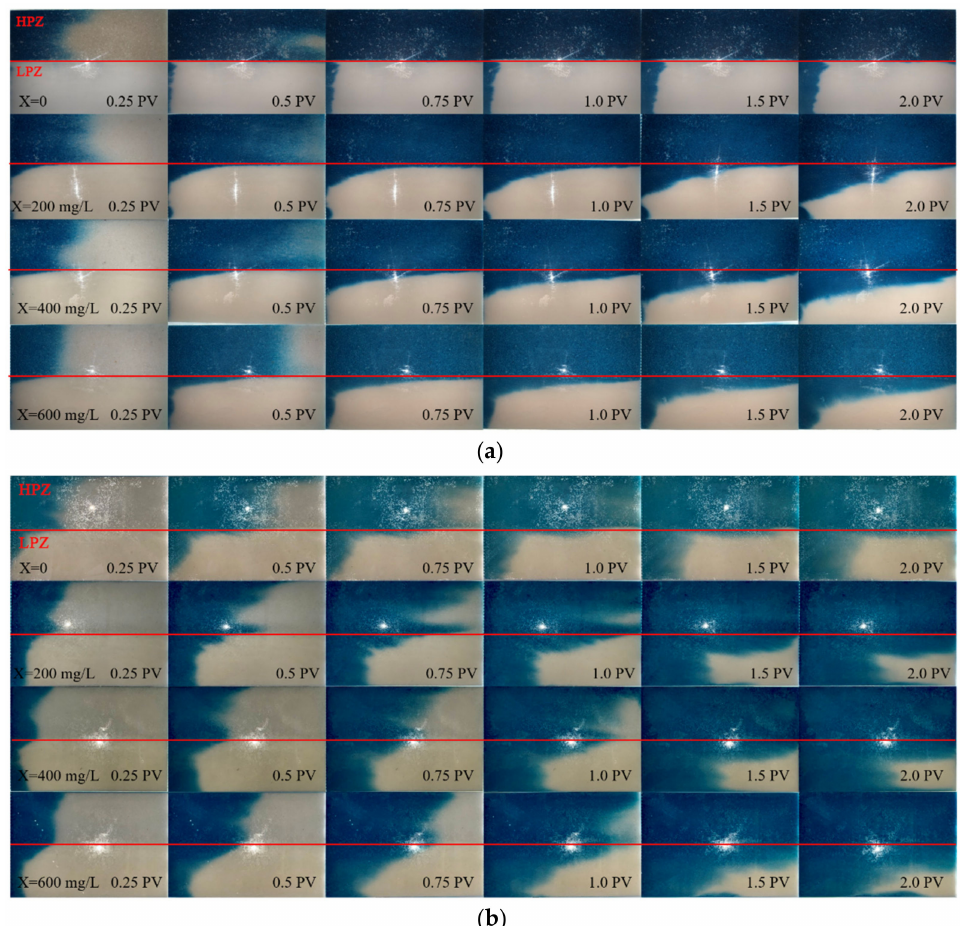
Figure 3. Transmission of xanthan gum in heterogeneous media. ( a ) Coarse sand/fine sand; ( b ) medium sand/fine